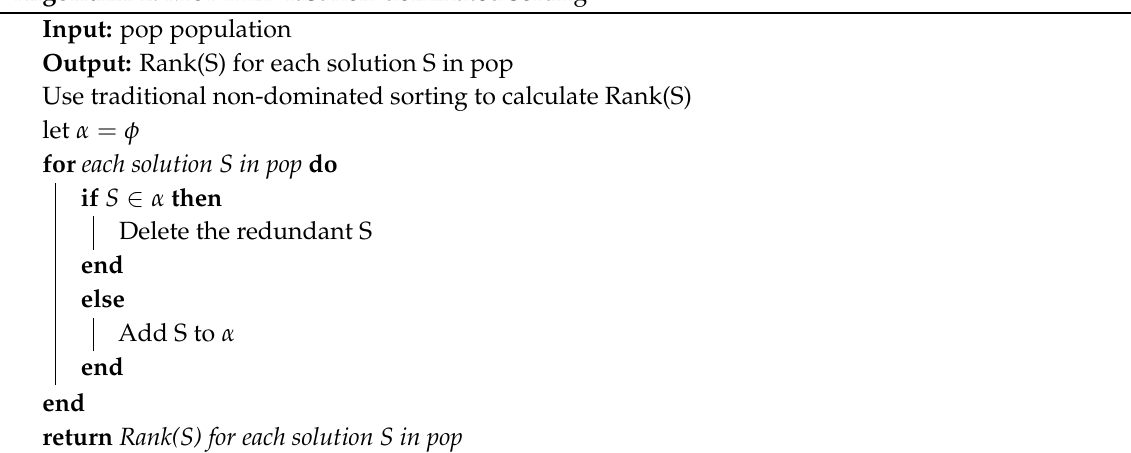
Algorithm 2: M ODIFIED fast non-dominated